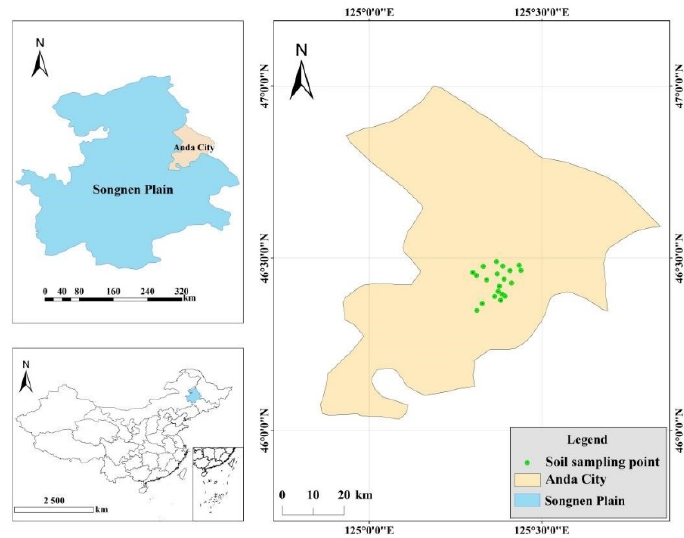
Figure 1. The location of the research area and the field plots.